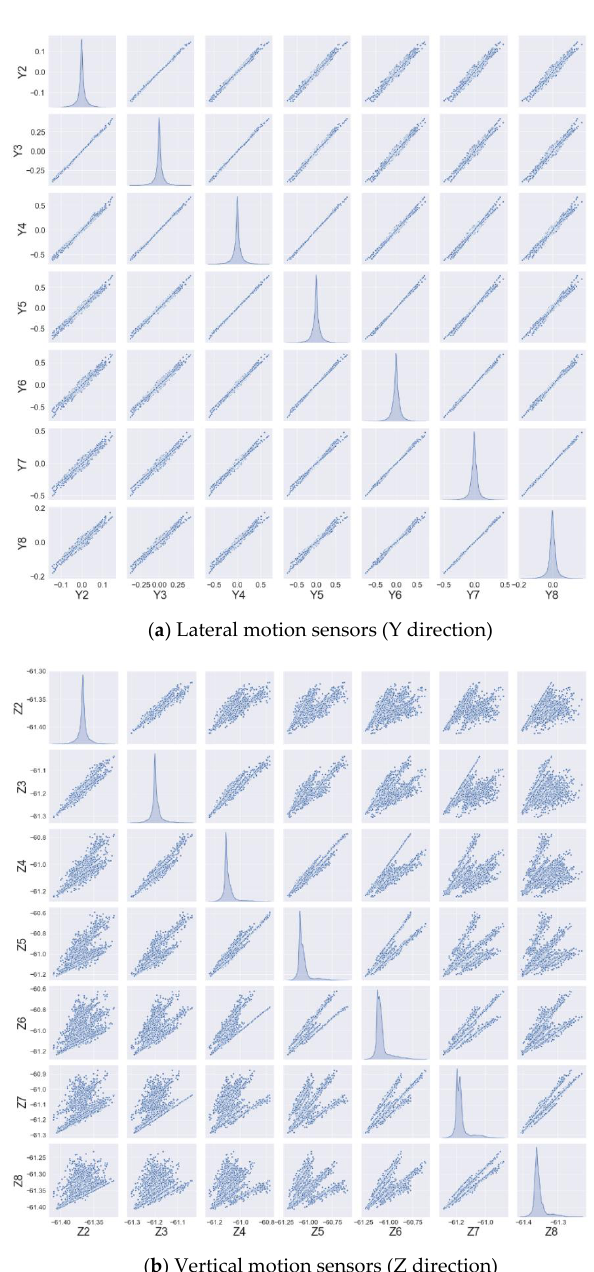
Figure 10. Correlation of numerical sensor data for lateral ( a ) and vertical ( b ) motions.